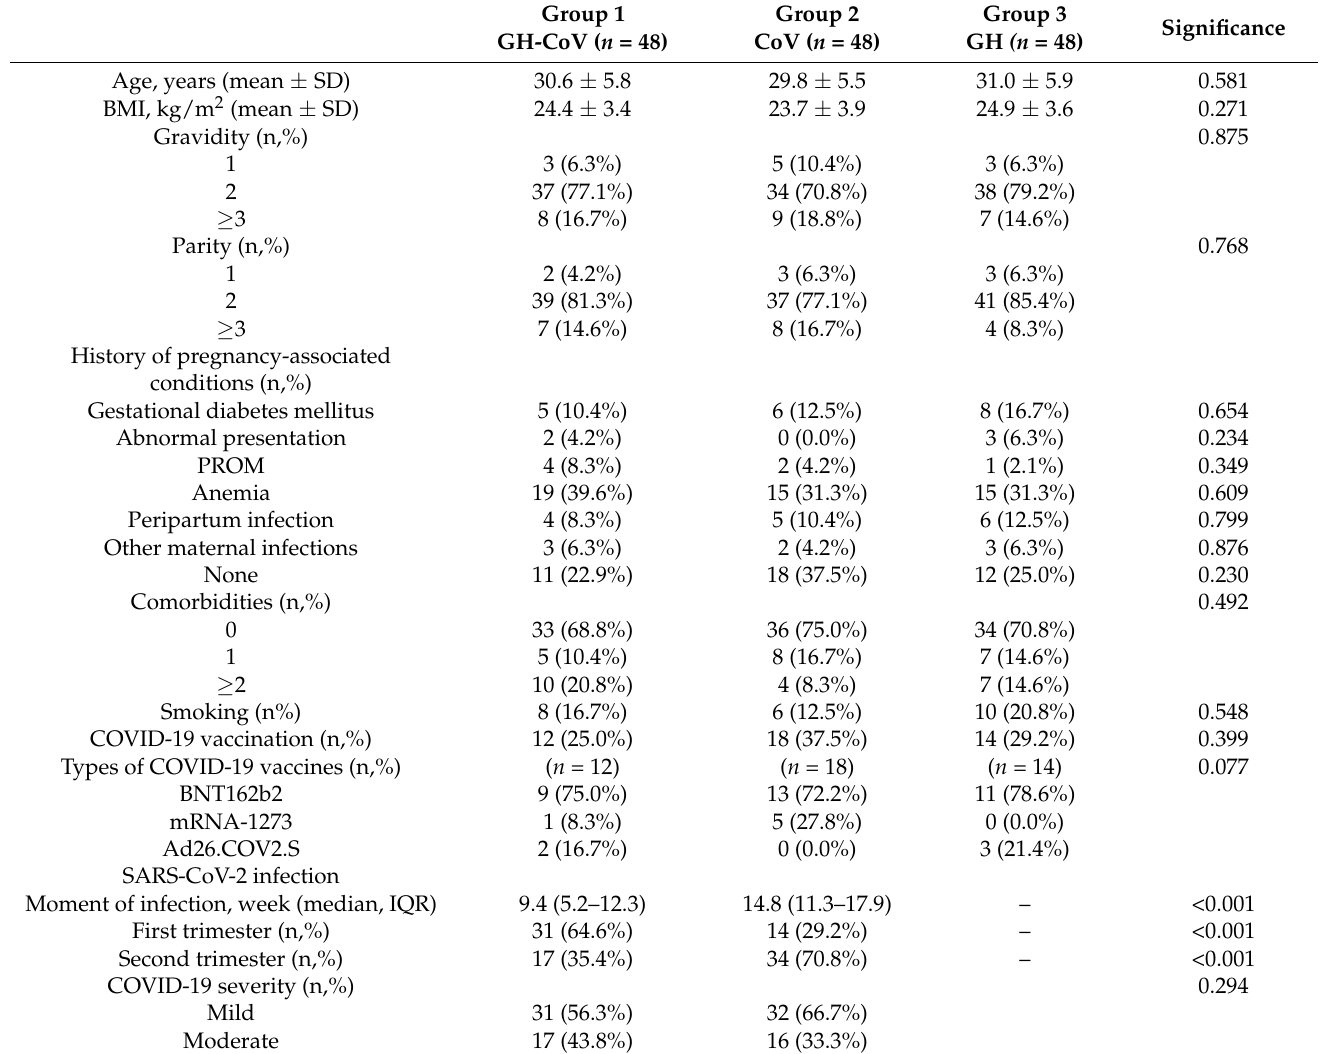
Table 1. General and obstetrical